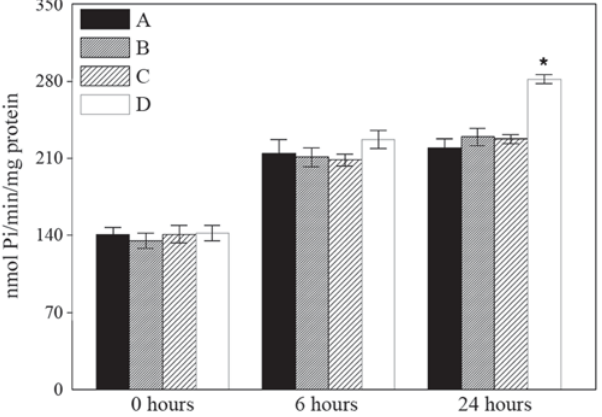
Fig. 1. ATP hydrolysis in supernatant of whole brain of silver catfish.